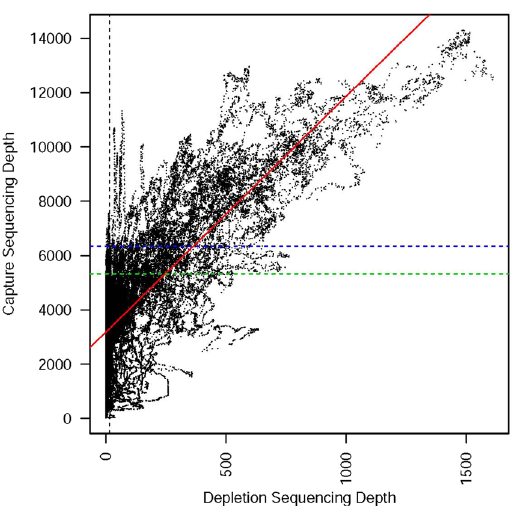
Figure 2. Scatterplot of Sequencing Depth Measurements for Capture and Depletion Data. The sequencing depth values for the capture data and the depletion data are plotted for every position in the reference genome. As expected, there is a positive linear correlation between the two values (red line, p-value: < 2e-16, R-squared = 0.307). Our thresholds for predicting nuwts are overlaid on this plot with 16X sequencing depth being the previously established 17 threshold for the depletion data (black dotted line) and the second and third standard deviations from the mean being the thresholds for the capture data (green and blue dotted lines,